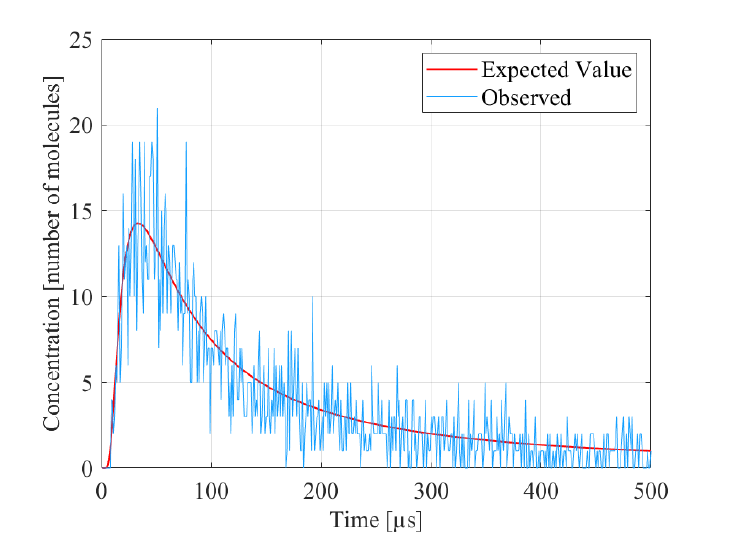
Figure 1. Example illustrating the expected and observed concentrations for a diffusion-based MC channel, assuming number of molecules ( N molec ) = 10,000, d = 0.3 µ m, D = 450 µ m 2 /s , and a rx = 50